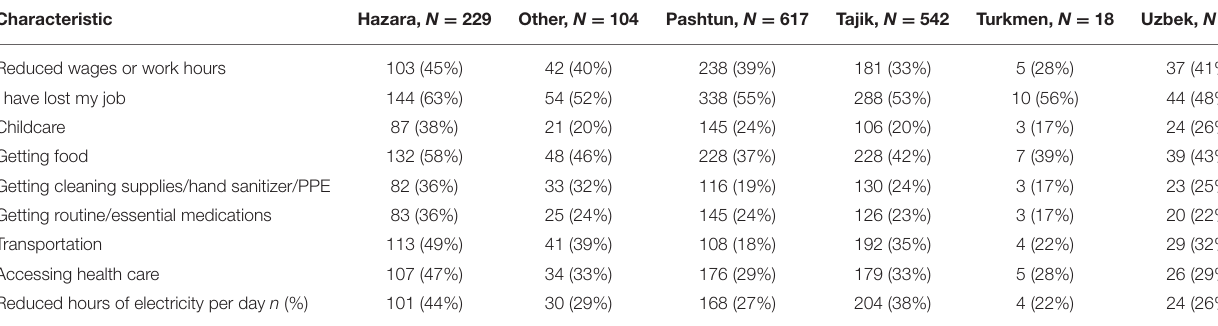
TABLE 3 | Difficulties experienced following the US